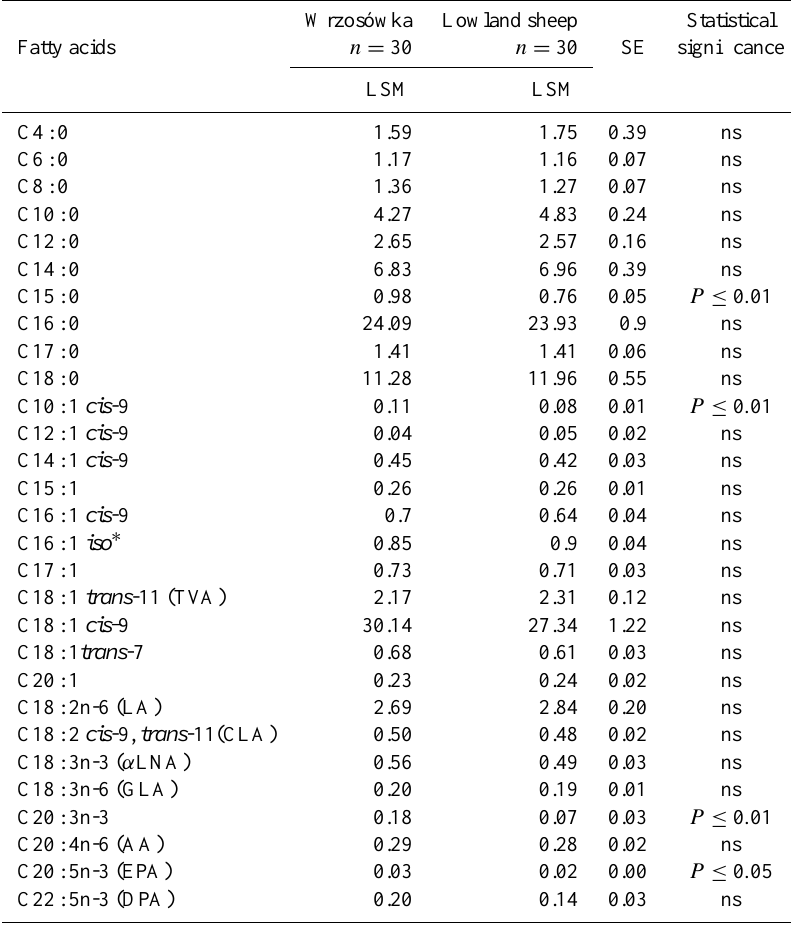
Table 4. The fatty acid profile (g100g − 1 fat) in milk fat of examined sheep breeds. Wrzosówka Lowland sheep Statistical Fatty acids